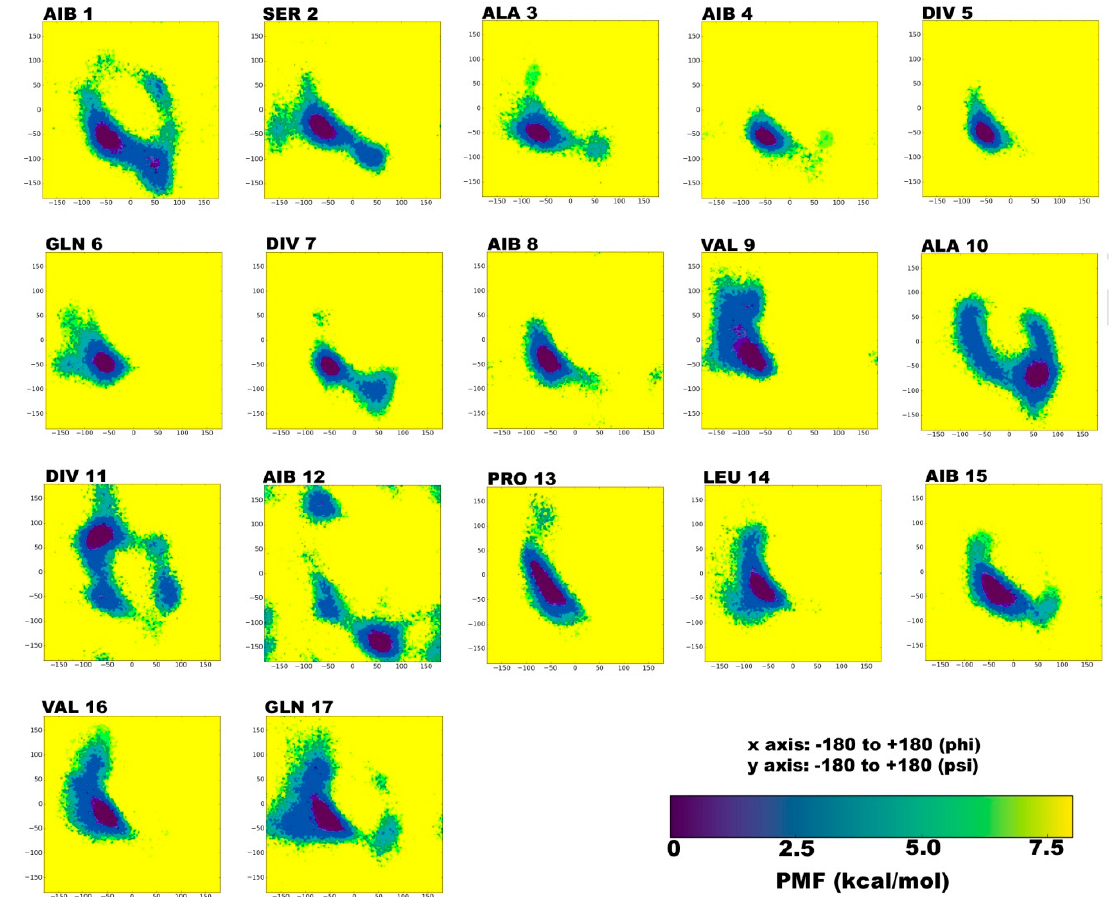
Figure 2. Reweighted PMF (potential of mean force) phi-psi dihedral angle plots for each TPN XIIc residue during explicit chloroform aMD simulation. The x and y axes range from -180 to +180. The darkest violet regions indicate toward minimum energy secondary structural regions favored by each residue during the simulation.